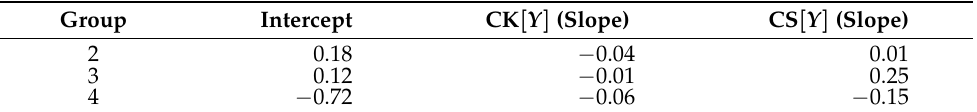
Table 10. Results of the fit with a multinominal logistic regression model for the simulation study.